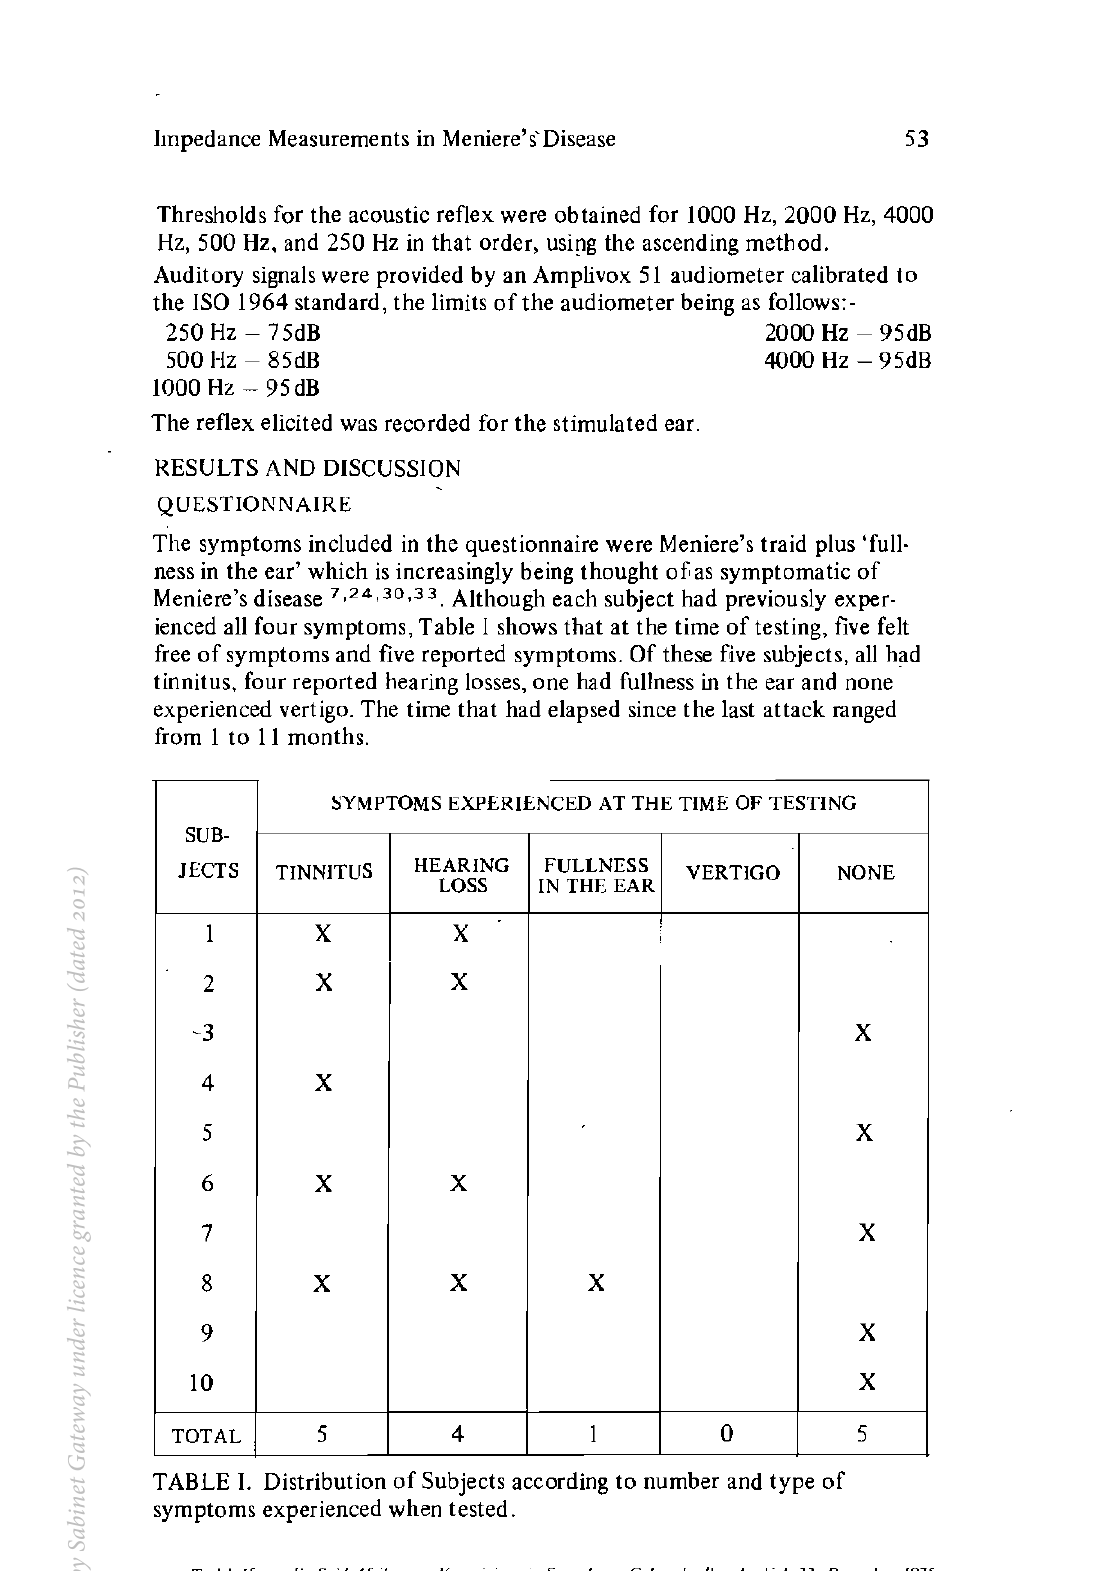
TABLE I. Distribution of Subjects according to number and type of symptoms experienced when